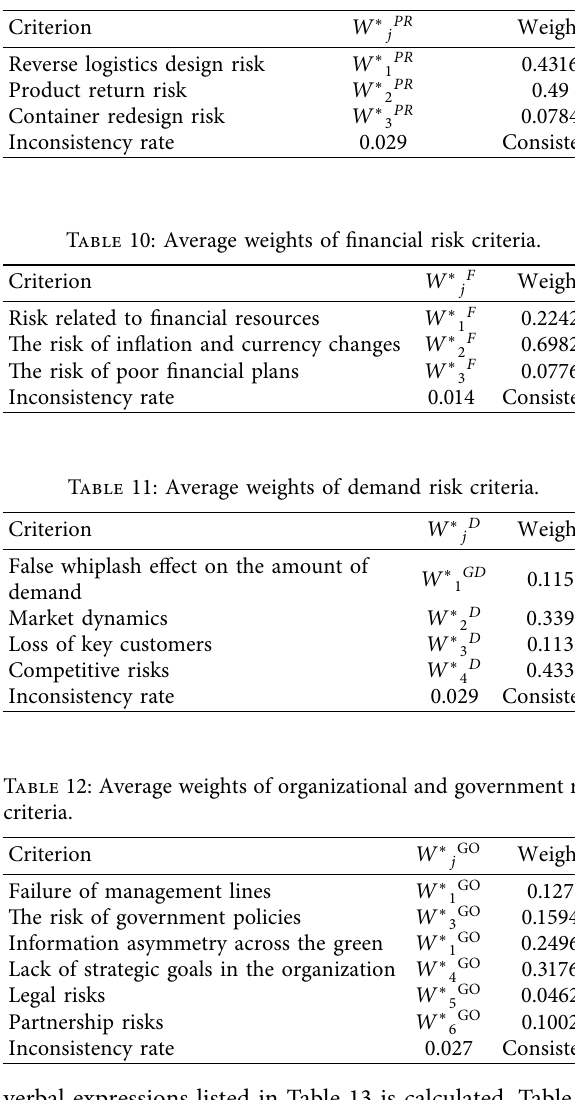
Table 9: Average weights of product return risk criteria.